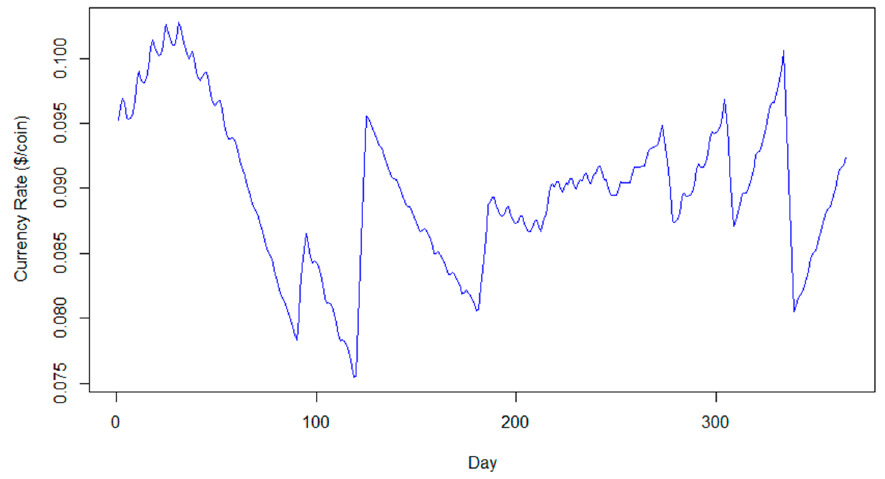
Figure 2. Daily currency rate for 365 days.